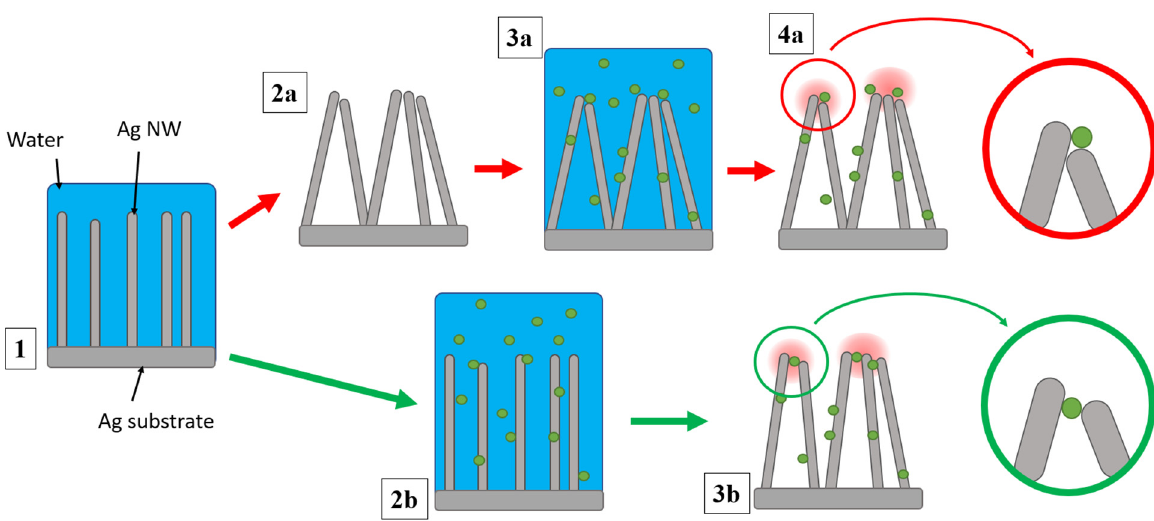
Figure 4. Schematic procedure for the gap hot spots formation on the array of Ag-NWs bundles in case of the «dry» and «wet» SERS-substrates. ( 1 ) The array of Ag-NWs on a metal substrate is being in the water after etching of TM. ( 2a ) as distilled water was evaporated, Ag-NWs were leant together by its tips due to the capillary force. ( 3a ) An analyte was added on the already formed Ag-NWs bundles, so the analyte molecules could not be in the spacing between neighboring Ag-NWs tips and consequently in the gap hot spot region ( 4a ). ( 2b ) an analyte was added on wet substrates. ( 3b ) Molecules of an analyte were adsorbed on the entire length of the Ag-NWs, and during the Ag-NWs leaning, the molecules were trapped in the gap hot spot region.